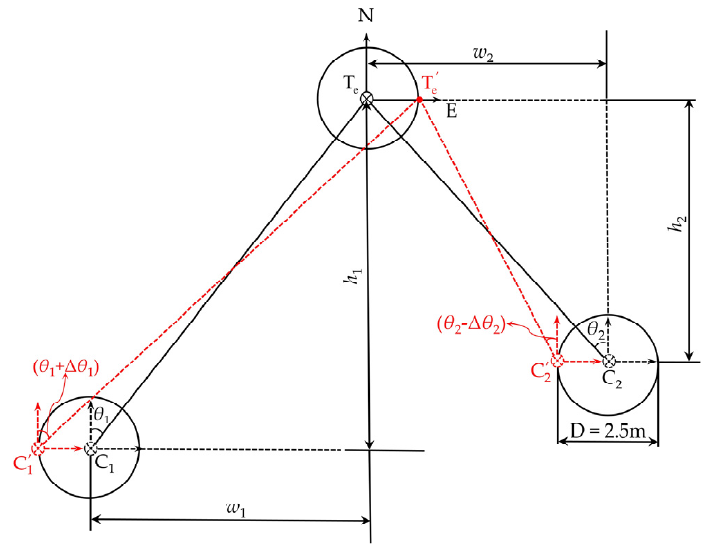
Figure 13. Vertical displacement correction results: ( a ) measured vertical displacement before cor- rection; ( b ) vertical displacement before correction.